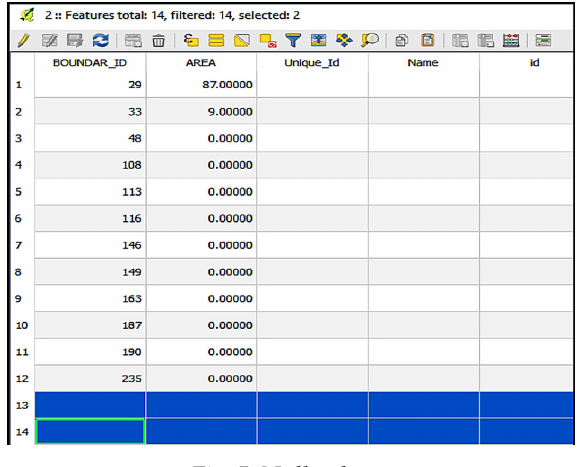
Fig. 5. Null values.